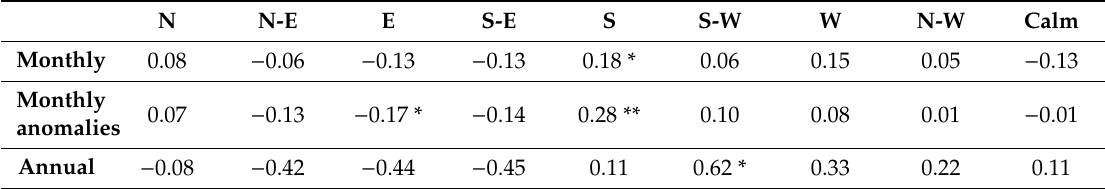
Table 3. Correlation values between the monthly and annual time series of the number of KD onsets and the monthly or annual number of occurrences of one of the nine wind directions and intensity regimes over Emilia. N, N-E, E, S-E, S, S-W, W, N-W stand for the frequency of the nine wind compass direction regimes, while Calm stands for calm day frequency. "Monthly anomalies" indicate the correlation between the time series removed of their seasonality.